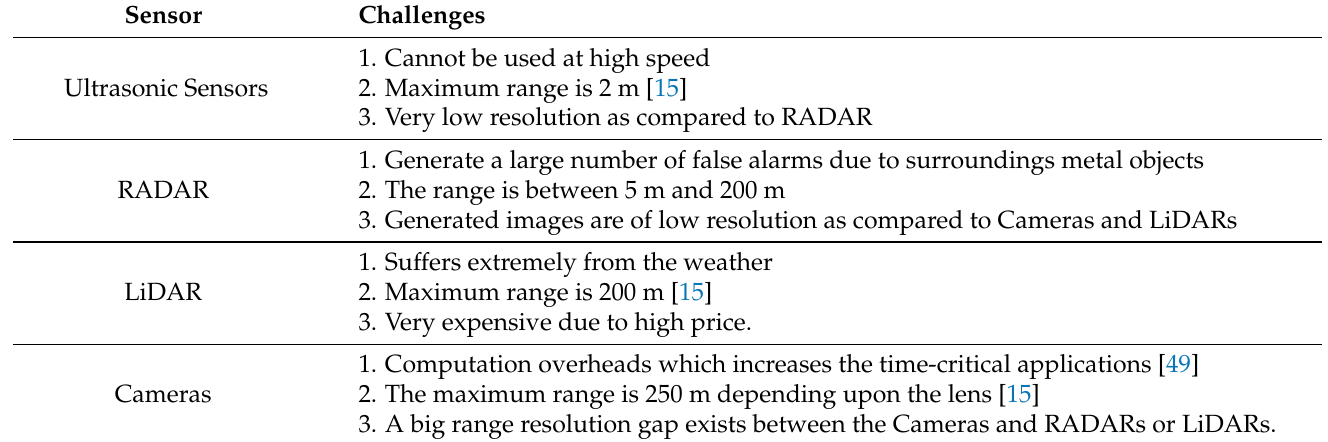
Table 4. Comparison of sensor and their